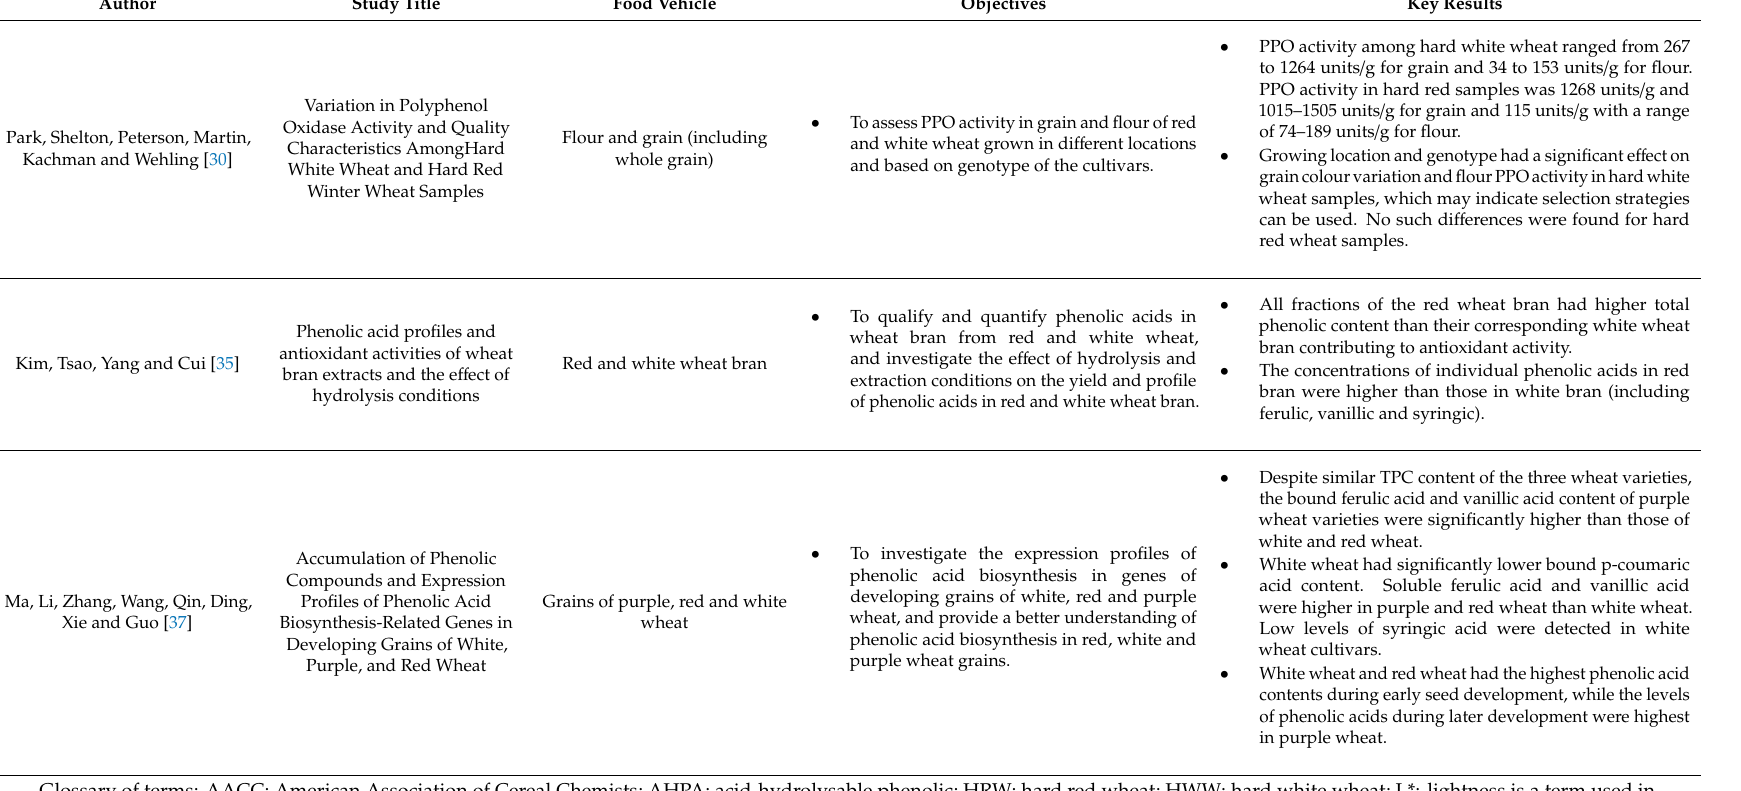
Table 3. Red and white wheat physico-chemical studies published